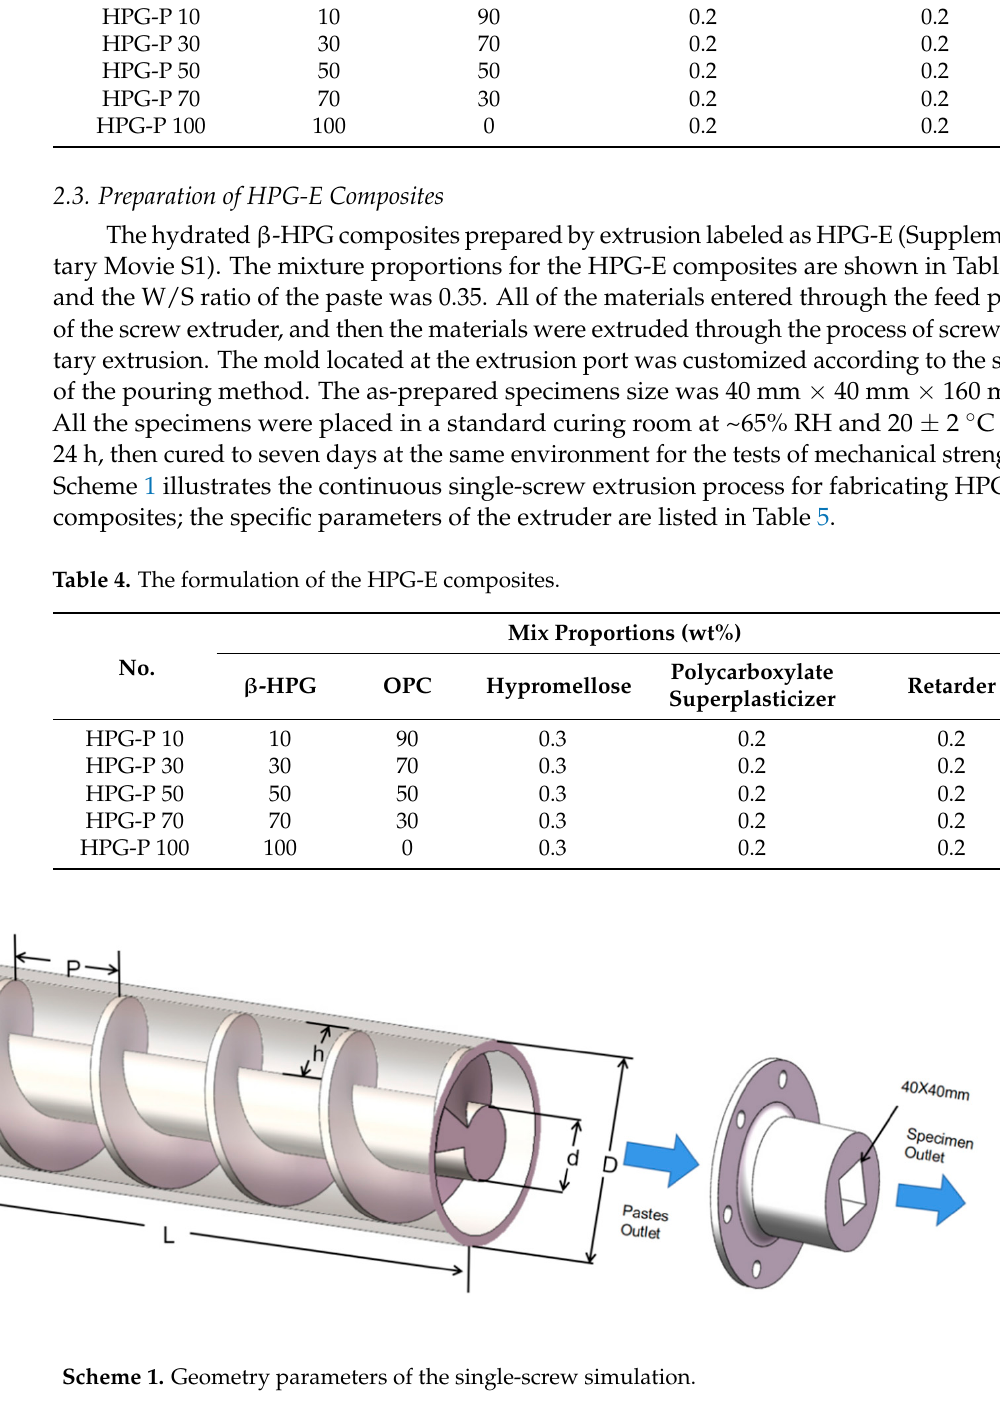
a vibration table. Specimens were molded at 20 ± 2 ° C, 60 ± 5% RH for 24 h, then demolded and cured for seven days in the same environment for the tests of mechanical strength. Table 3. The formulation of the HPG-P composites.